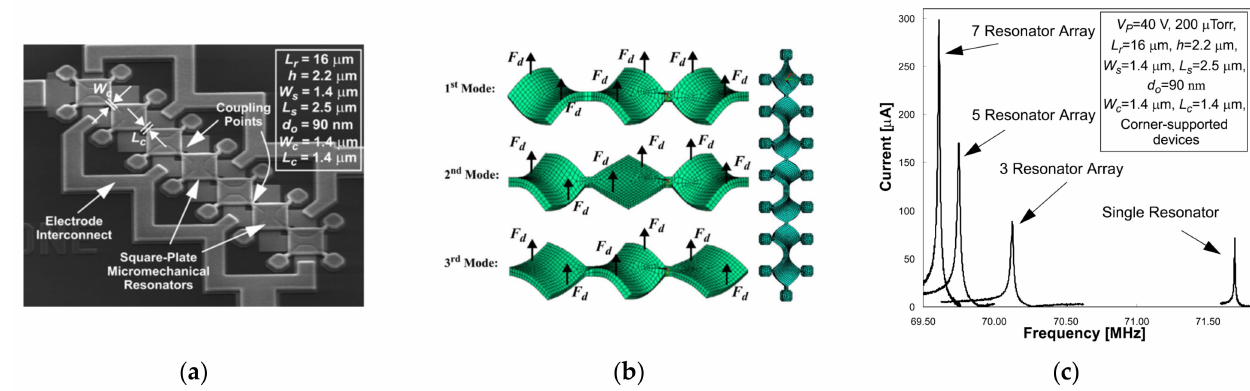
Figure 30. ( a ) SEM image of a 7-DoF strongly coupled BAW resonator system with anchors at the center; ( b ) FEM simulated out-of-plane motion of the coupled resonator systems; ( c ) Frequency response of several multi-DoF coupled resonators. Reprinted with permission from Ref. [37].